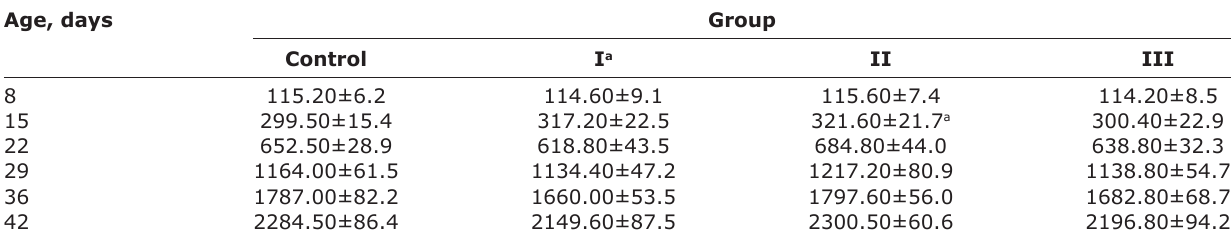
Table-5: Weekly broiler chicken weight gain,